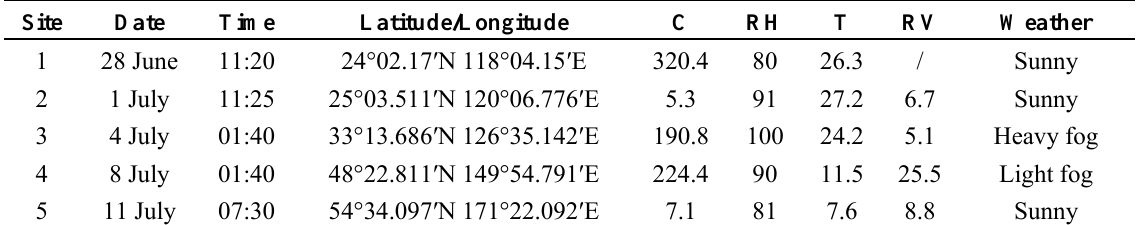
Table 1. Sampling location, date, fungal concentrations and meteorological conditions during the CHINARE